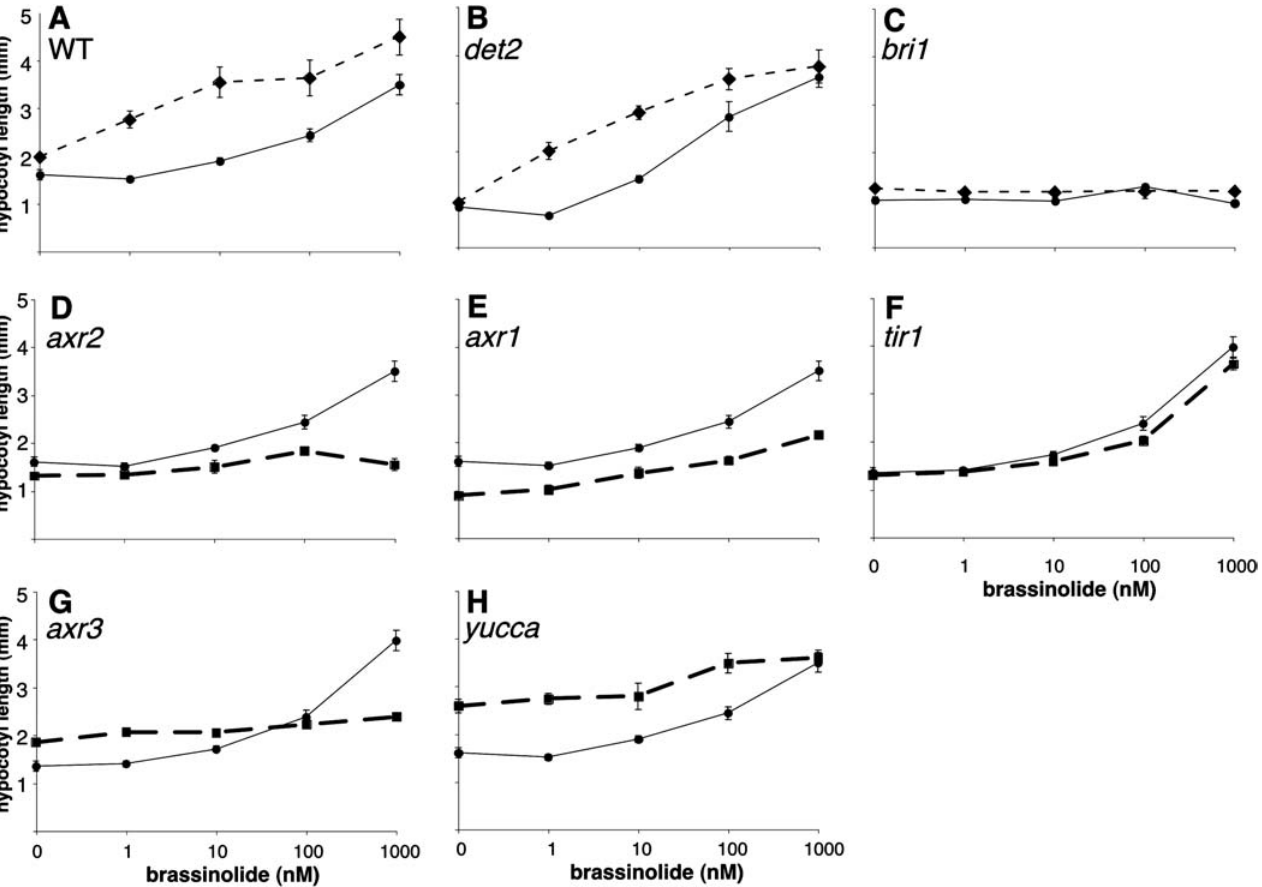
Figure 1. BR and Auxin Pathways Are Interdependent, as Measured by Hypocotyl Elongation (A) Mild temperature elevation causes elongation of the hypocotyl and BR hypersensitivity in WT plants. Columbia ecotype is shown but results are similar for Wassilewskija. Hypocotyls of 3-d-old plants grown at either 26 8 C (diamonds, dashed line) or 22 8 C (circles, solid line) were measured. (B) det2-1 plants are defective in BR biosynthesis and are also insensitive to the temperature increase. As the det2 deficiency is rescued by exogenous BL, temperature sensitivity is restored. (C) Plants with the weak bri1-5 mutation are insensitive both to temperature and exogenous BR. (D–H) BR response depends upon auxin response. WT is shown in circles with a solid thin line and mutants are shown in squares with a thick dashed line. Known auxin response mutants axr2-1 (D), axr1-12 (E), tir1-1 (F), and axr3-1 (G) have decreased BR response. (F) tir1 has no hypocotyl elongation phenotype in the absence of exogenous hormone treatment and only very modest effects on BR sensitivity. Response is significantly reduced in tir1 mutants at 100 nM BL, as measured by Student’s t-test ( p = 0.03, using Bonferroni adjustment for multiple tests; Hochberg 1988). (H) yucca plants, which overproduce auxin, also show reduced BR response. Error bars represent standard error. Data in (F) and (G) were collected in a separate experiment from other panels, resulting in small differences in the values for WT hypocotyl